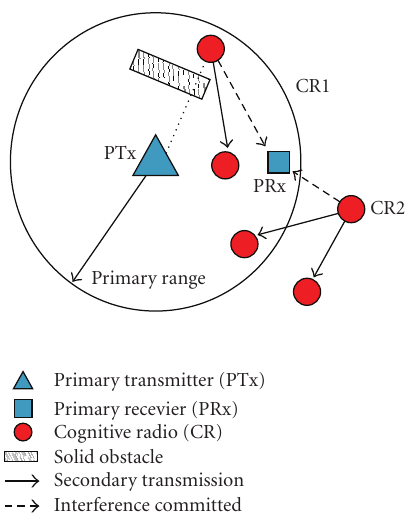
Figure 2: Examples of secondary interferences by cognitive sensors.